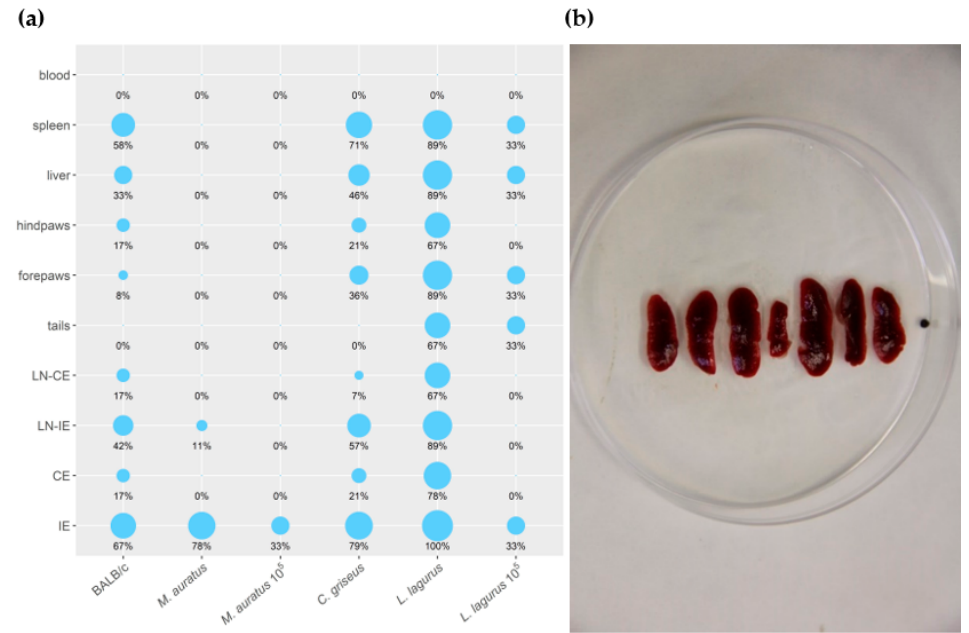
Figure 4. ( a ) Anatomical distribution of L. donovani in rodent species determined by qPCR. Results are presented by the balloon graph where the size of the balloon corresponds to the percentage of L. donovani infected organs from the total sum of tested organs of the same type. IE = inoculated ears; CE = contralateral ears; LN-IE = draining lymph nodes of the inoculated ears; LN-CE = draining lymph nodes of the contralateral ears. 10 5 : Animals inoculated with 10 5 CDP. Animals that are not 10 5 –labeled were inoculated with 10 7 CDP or SDP ( b ) Splenomegaly in L. lagurus infected with L. donovani in comparison with uninfected control animal (in the centre). Table 3. Results of xenodiagnosis experiments performed with P. orientalis in the four rodent species infected with L. donovani